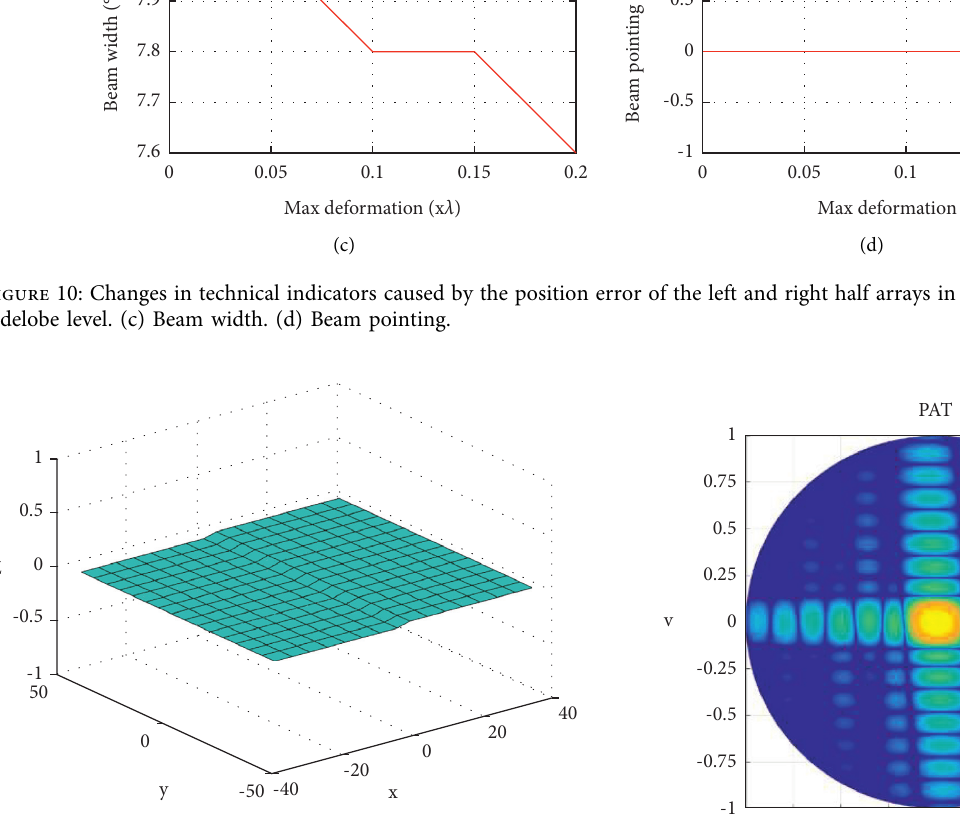
Figure 11: Position error of the left and right half arrays in the Y - direction.